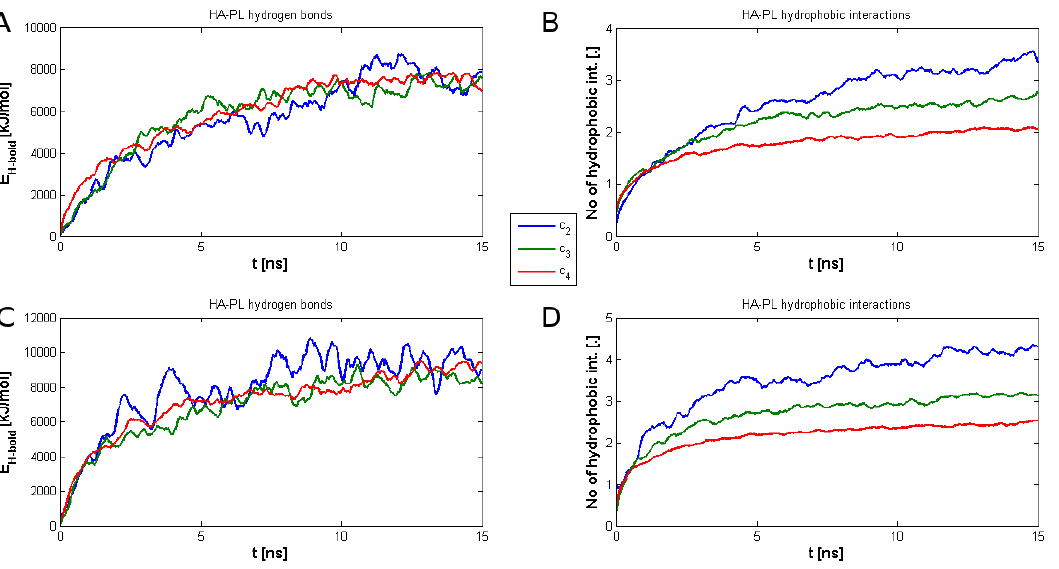
Figure 7. Normalized H-bond energy and hydrophobic interactions between HA and PL per one phospholipid: ( A , B ) inter-molecular networks are depicted; and ( C , D ) intra-molecular networks.